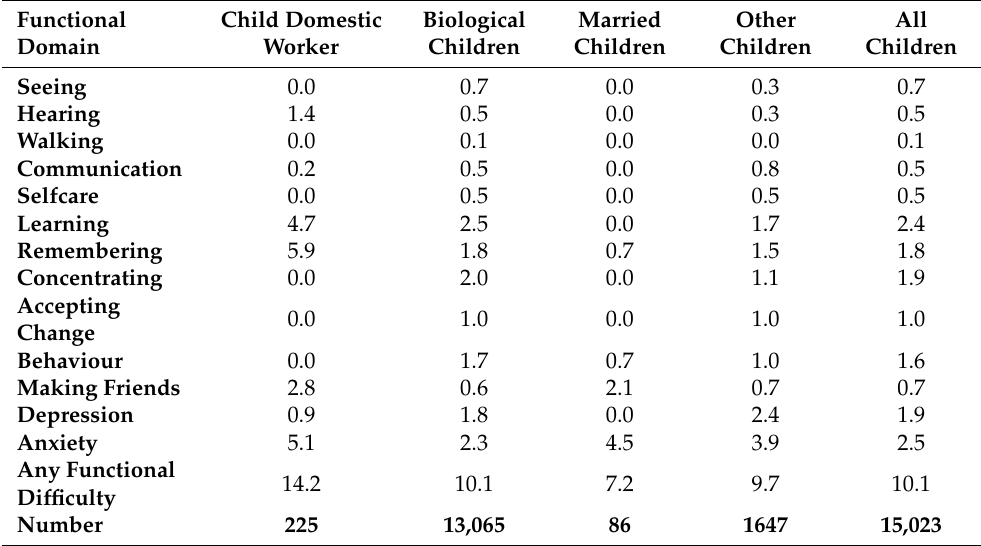
Table 7. Proportion of children with Functional Difficulties ( N = 15,023, %).